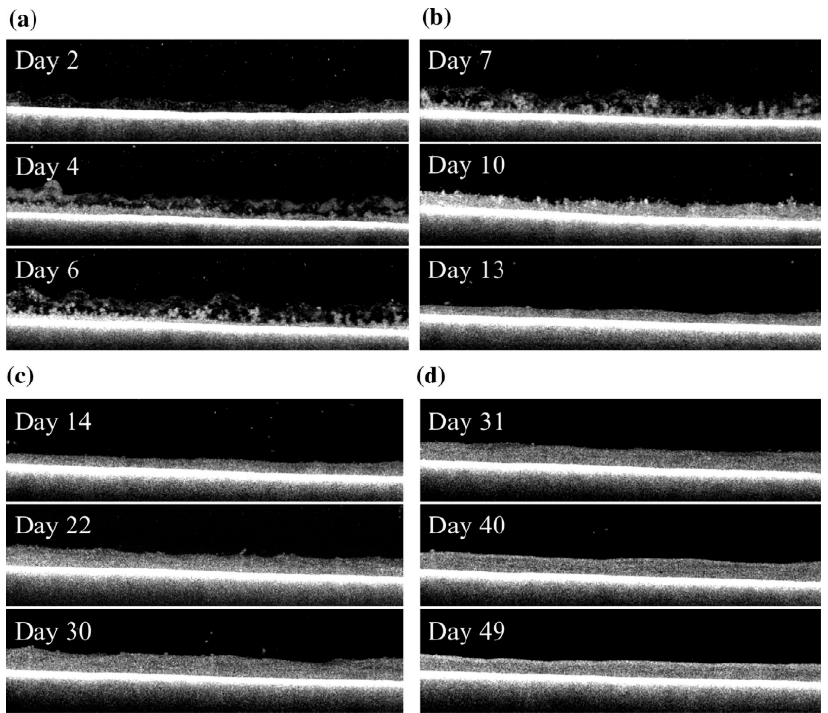
Figure 8. Evolution of fouling morphology by optical coherence tomography scanning: ( a ) phase I, ( b ) phase II, ( c ) phase III, and ( d ) phase IV. Reprinted with permission from Ref. [62]. Copyright 2014 Elsevier.